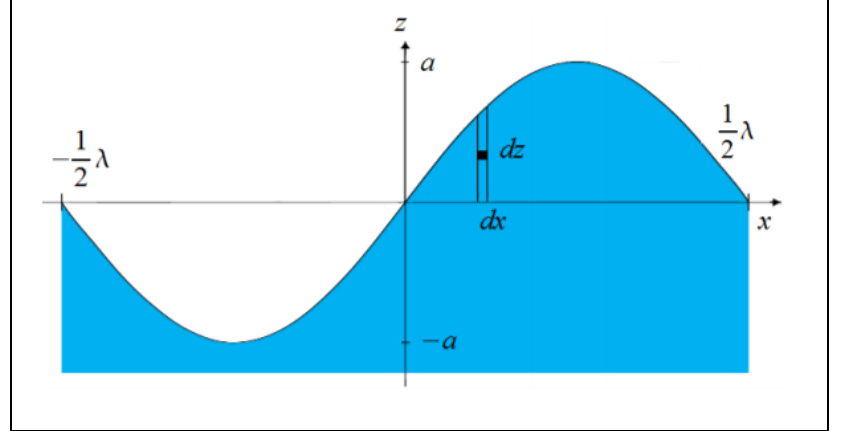
Figure 20. Energy content of a surface sine wave [48].